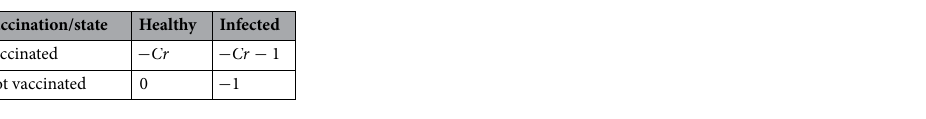
Table 1. Classification of individual’s gain according to the health